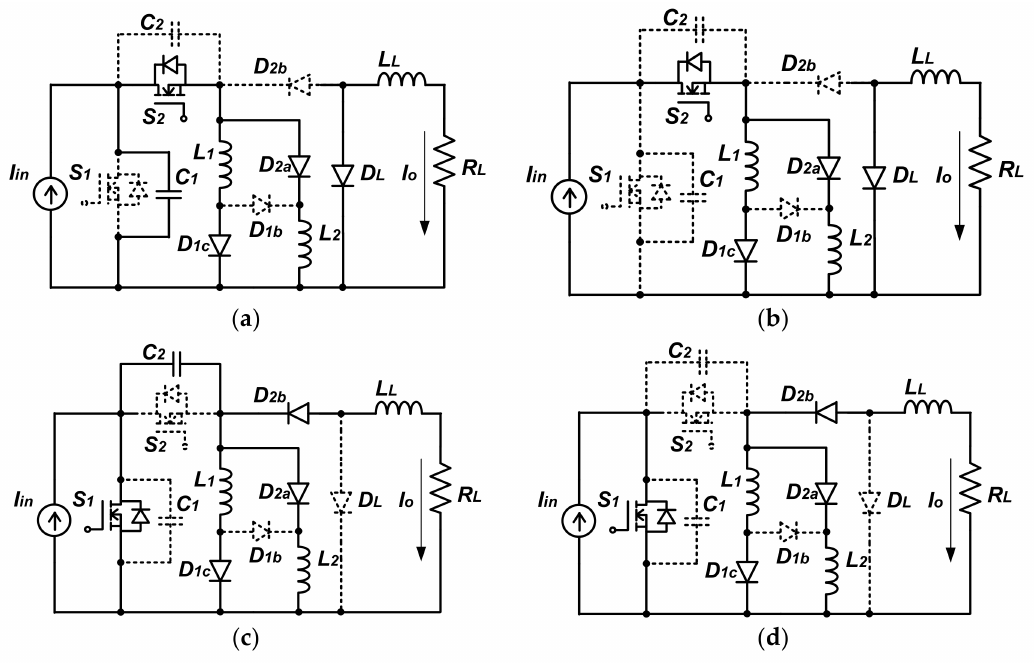
Figure 8. The equivalent circuit to show 4 stages for inverting 1/2-type SDRSIC; ( a ) Stage 1, ( b ) Stage 2, ( c ) Stage 3, ( d ) Stage 4.